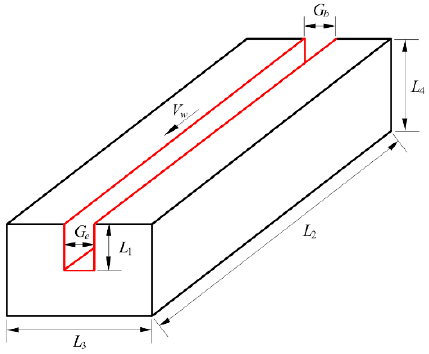
Figure 8. Illustration of test piece.